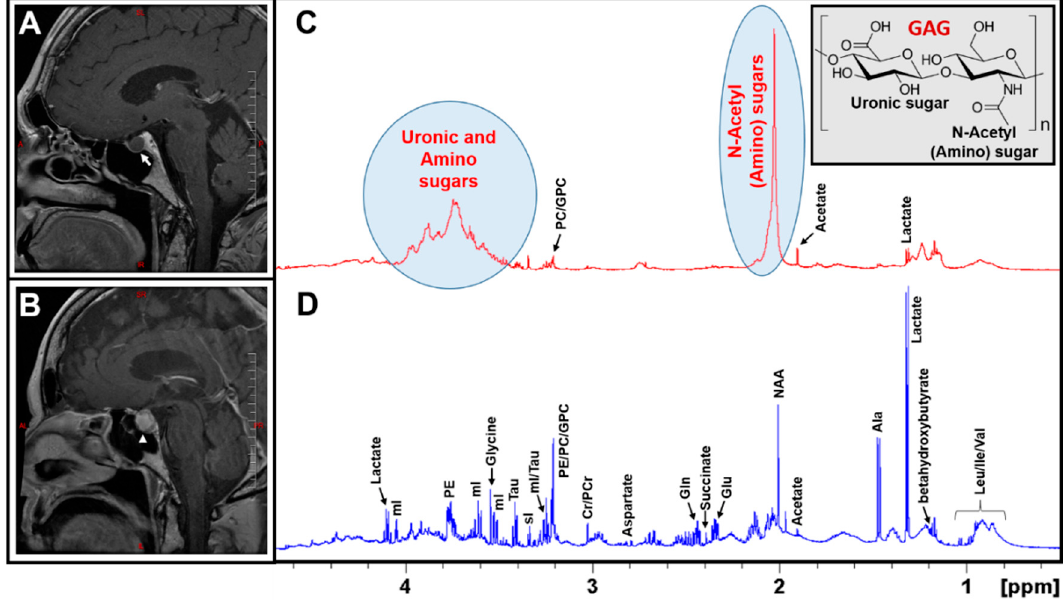
Figure 1. Post-contrast sagittal T 1 -weighted MR images of a Rathke’s Cleft Cyst RCC ( A ), an NF Pituitary adenoma ( B ); a thin peripheral enhancement on the post-contrast imaging in RCC is marked by a white arrow in Figure 1A, whereas the pituitary adenoma is marked with an arrow-head in Figure 1B. Typical 1 H NMR spectra of aqueous metabolites of an RCC and an NF pituitary adenoma are shown in ( C , D ), respectively. It is worthwhile to note that RCCs exclusively showed the presence of N-acetyl and uronic sugars arising from glycosaminoglycans (GAGs). Also shown is the partial molecular structure of a GAG (Inset of Figure 1C).